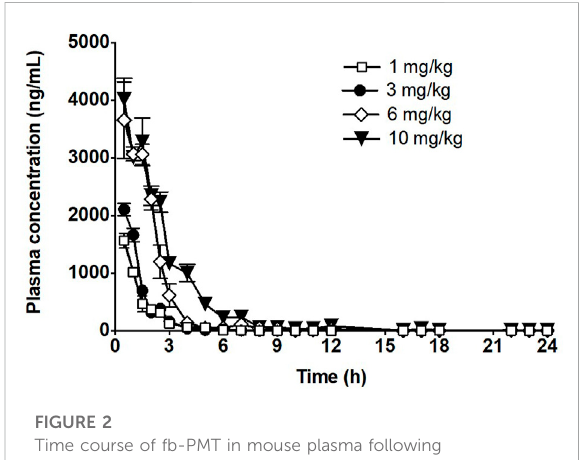
FIGURE 2 Time course of fb-PMT in mouse plasma following subcutaneous administration of fb-PMT. Data represent mean levels ±SD, (Hay et al., 2021).